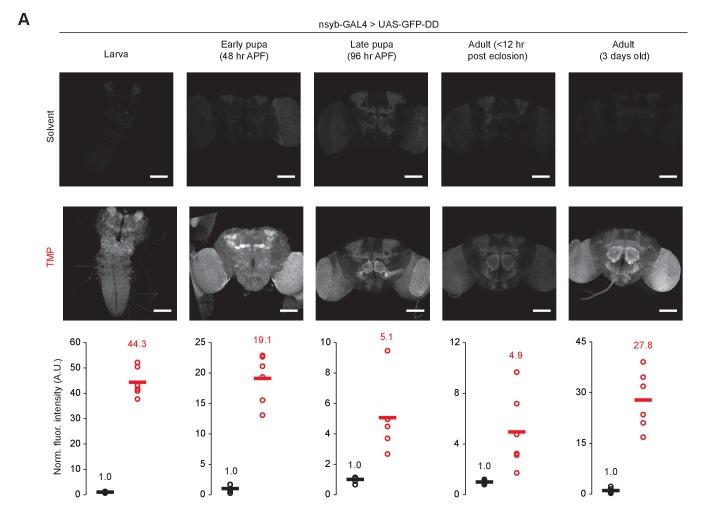
TMP-dependent GFP expression in the whole brain across developmental stages. Panels from left to right: Larva, Early pupa (48 hr APF), Late pupa (96 hr APF), Adult (<12 hr post eclosion), Adult (3 day old). Fluorescence intensity has been normalized to the mean fluorescence intensity from the brains of flies fed with the solvent. Scale bar = 100 μm. Differences in GFP expression between solvent and TMP fed flies are significant (unpaired t-test, two-tailed) across all developmental stages - Larva (p<0.001, t = 18.6, n = 6), Early pupa (p<0.001, t = 10.89, n = 5–6), Late pupa (p=0.025, t = 3.46, n = 5–6), Adult at eclosion (p=0.022, t = 3.25, n = 6), 3 day old adult (p<0.001, t = 7.55, n = 6).10.7554/eLife.30327.005Figure 1—figure supplement 2—source data 1.Effect of TMP feeding on GFP-DD fluorescent intensity across developmental stages.